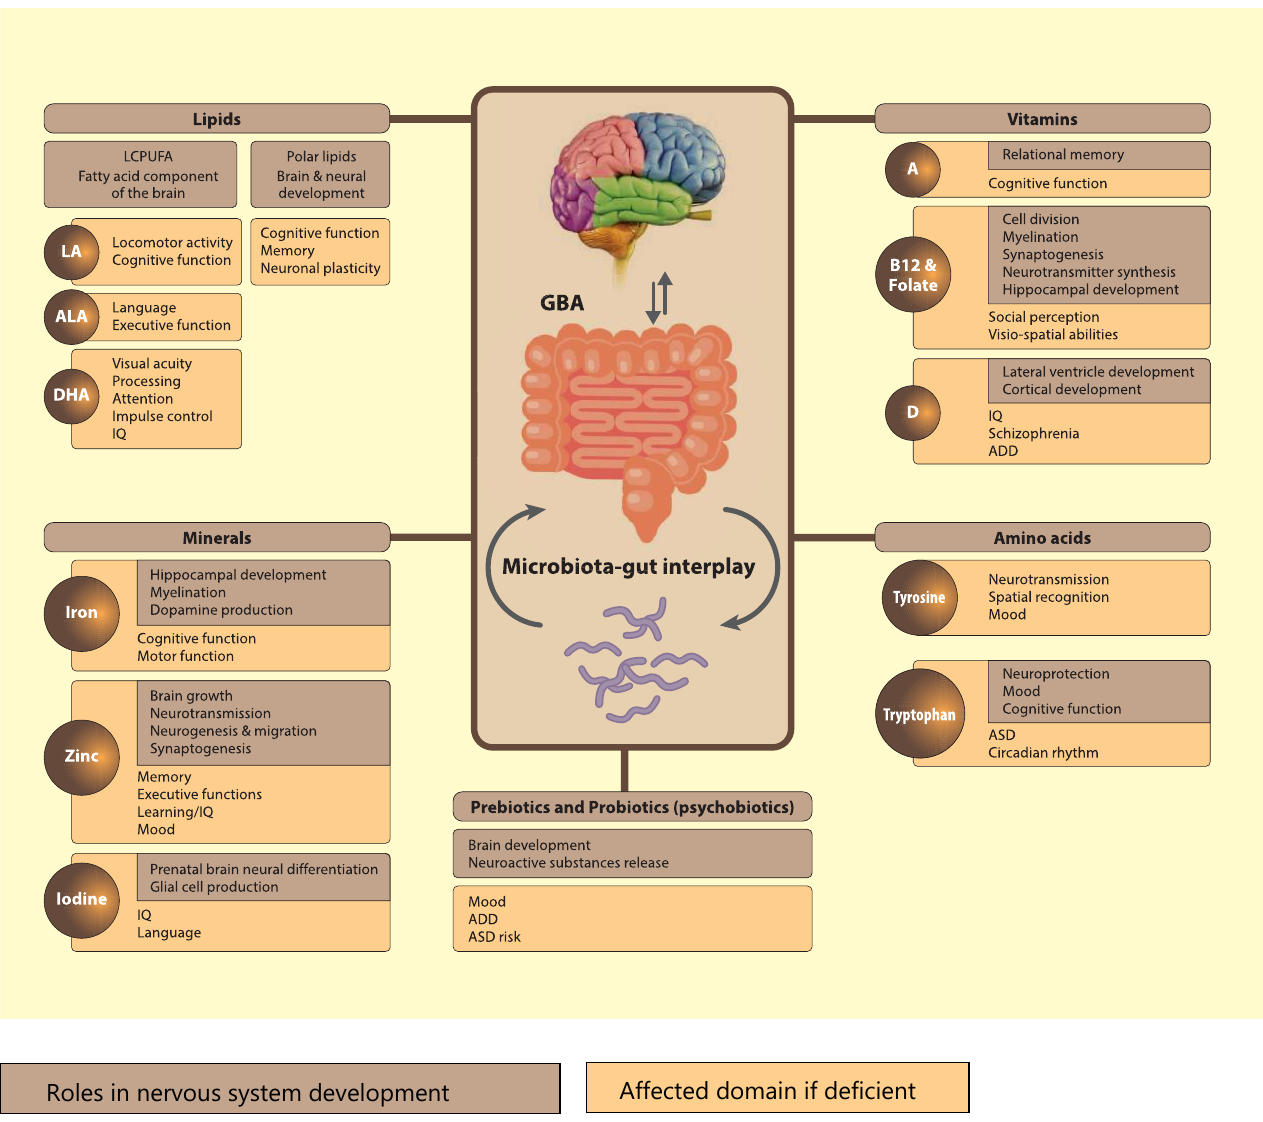
Figure 2. Functions and effect of some nutrients on brain and neuronal development. It also includes pre-and probiotics and tryptophan-based interactions through the gut brain axis.